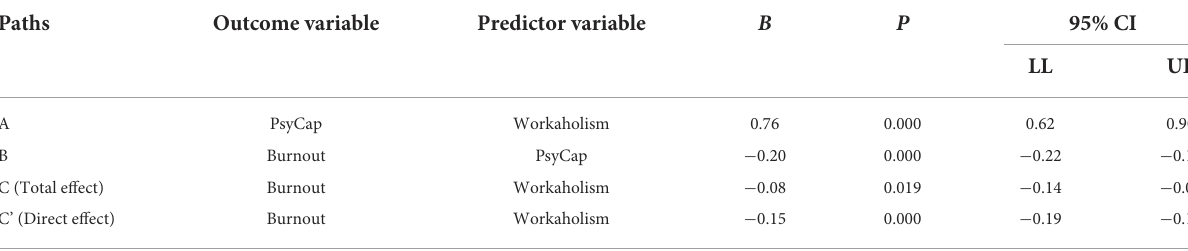
TABLE 2 Mediating role of PsyCap in the relationship of workaholism and burnout.